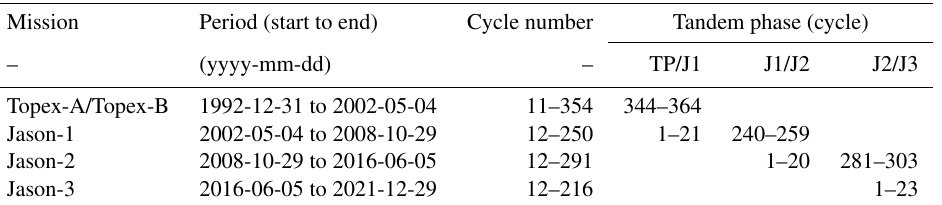
Table 2. Altimetry missions used to establish the CNES/AVISO+ GMSL record. The periods covered by each mission in the GMSL record are provided in the second column, the corresponding cycles are given in column three, and the tandem-phase cycles used to compute the intermission offsets are given in the last three columns.